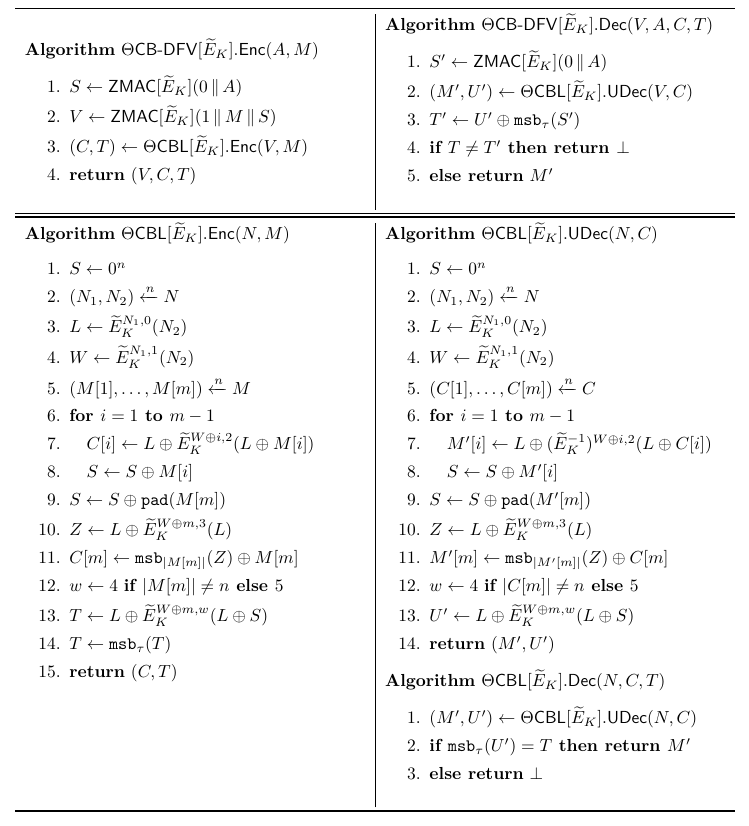
Figure 9: (Top) Θ CB-DFV , a TBC-based, full- n -bit-secure DFV . (Bottom) Θ CBL , an pNAE component of Θ CB-DFV with 2 n -bit nonce. ZMAC is in Figure